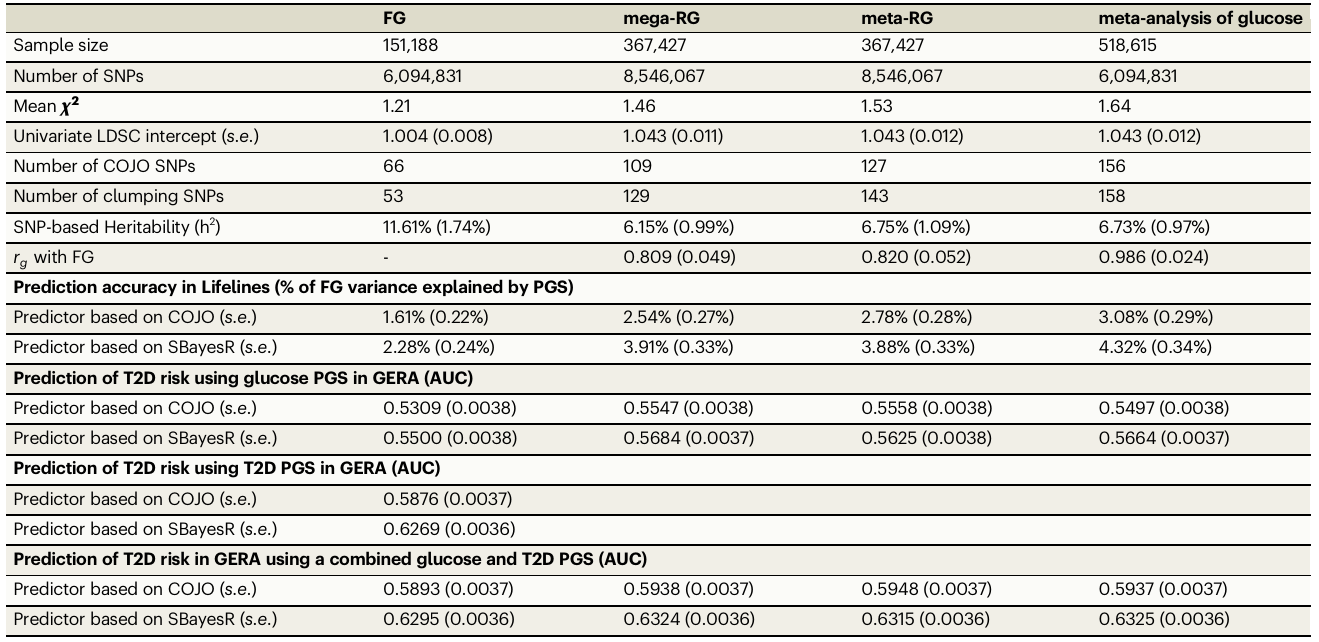
Table 2 | Summary of analyses performed on the four sets of GWAS summary data FG mega-RG meta-RG